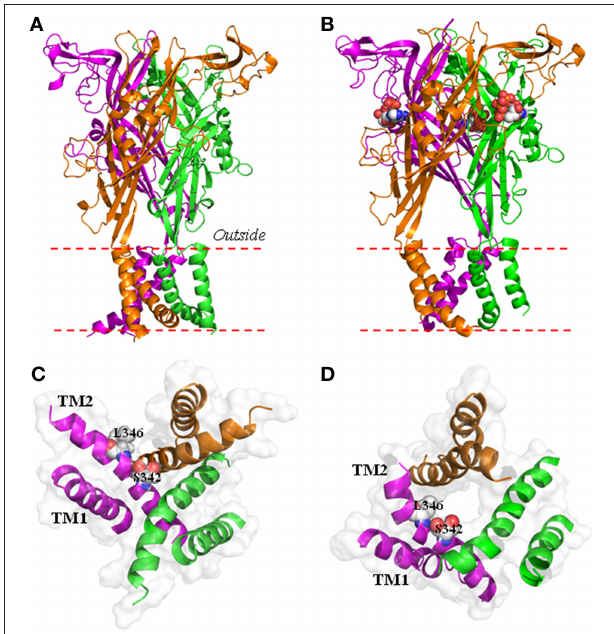
FIGURE 1 | Structural models of the human P2X7 ion channel in the closed and open state. (A,B) The structural models of the trimeric human P2X7 receptor in the closed (A) and open states (B) , viewed parallel to the plasma membrane. They are generated based on the crystal structures of zebrafish P2X4 receptor (4DW0 and 4DW1 respectively). Each subunit is shown in a different color. Three ATP molecules shown in space filling representation bind to the three inter-subunit interfaces (B) . (C,D) The transmembrane ion-permeating pathway in the structural models of the human P2X7 receptor in the closed (C) and open states (D) , viewed from the intracellular side of the membrane. The three TM1 helices are located at the periphery and the three TM2 helices in the center form the ion-conducting pathway. Ser342 and Leu346 from each of the three subunits provide the narrow part of the ion-conducting pathway in the open state (D)